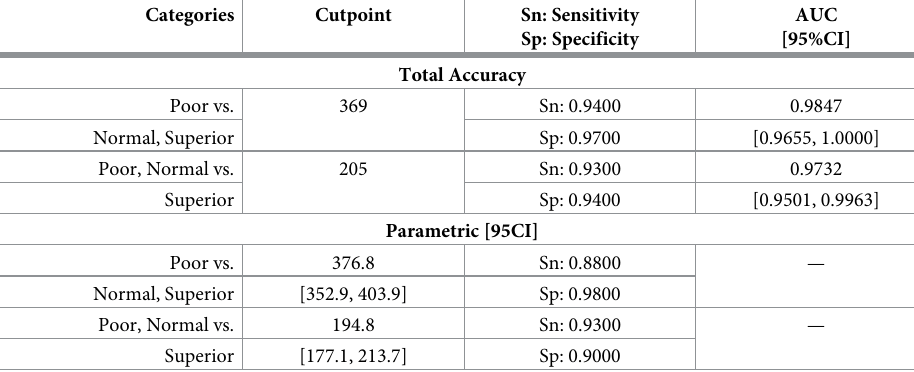
Table 8. Cork stopper quality (N = 150). Cutpoints of total defective area [px] discriminating cork stopper quality lev- els were selected from cumulative ROC curves with Total Accuracy criterion and computed parametrically. Propor- tional odds were assumed among quality